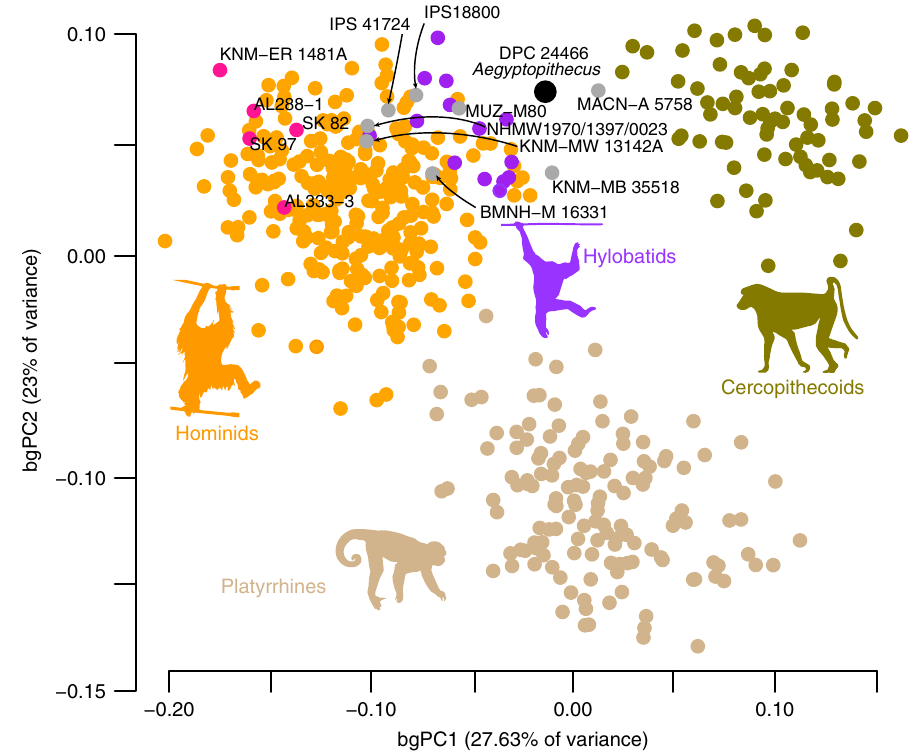
Fig. 2 Shape analysis of the anthropoid proximal femur. The plot shows the fi rst two principal components of an analysis carried out on the between-group covariance matrix (bgPCA). The groups represent extant species and fossil centroids, with individual specimens and fossils plotted post hoc. Thin-plate- spline (TPS) warped versions of DPC 24466 depicting extremes of variation along each axis are represented in Supplementary Fig 4. The colour codes are as follows: New World monkeys, light brown; Old World monkeys, green; great apes and humans, orange; hylobatids, purple; fossil hominins, pink; other fossil primates, grey; the Aegyptopithecus DPC 24466 femur is black. Taxonomic attributions of the fossils represented are: DPC 24466, Aegyptopithecus zeuxis ; MACN-A 5758, Homunculus patagonicus ; KNM-MB 35518, Victoriapithecus macinnesi ; NHMW1970/1397/0023, Epipliopithecus vindobonensis ;